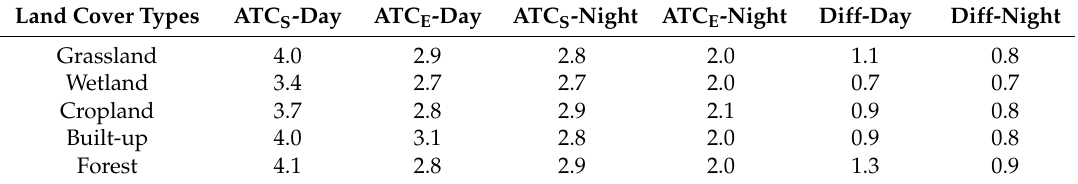
Figure 4. Spatial distributions on the predicted RMSEs for the ATC S (left) and ATC E (right) during the day ( a , b ) and the night ( c , d ). Table 2. Predicted RMSEs (unit: K) of the ATC S and ATC E for different land cover types. Diff-day and -night denote the accuracy improvements of the ATC S when referenced to the ATC E .